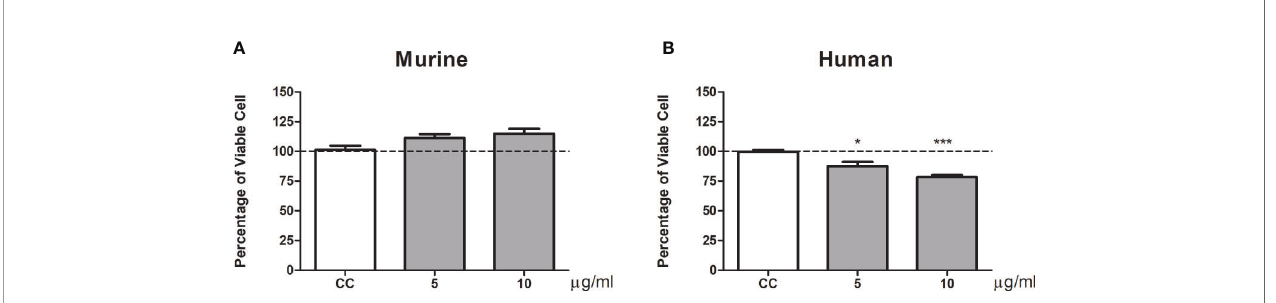
FIGURE 4 | Percentage of viable pulmonary fi broblasts stimulated by gp43. Fibroblasts were cultured in the presence or absence of gp43 and proliferation evaluated 24 h post-treatment using MTT assays. (A) Murine pulmonary fi broblasts. (B) Human pulmonary fi broblasts. Fibroblast proliferation was measured according to the ratio of test culture cells (challenged with exoantigens) to untreated culture control (CC) cells. Results are expressed as mean ± SEM; paired t-test; * p < 0.05, *** p < 0.001; n = 4.